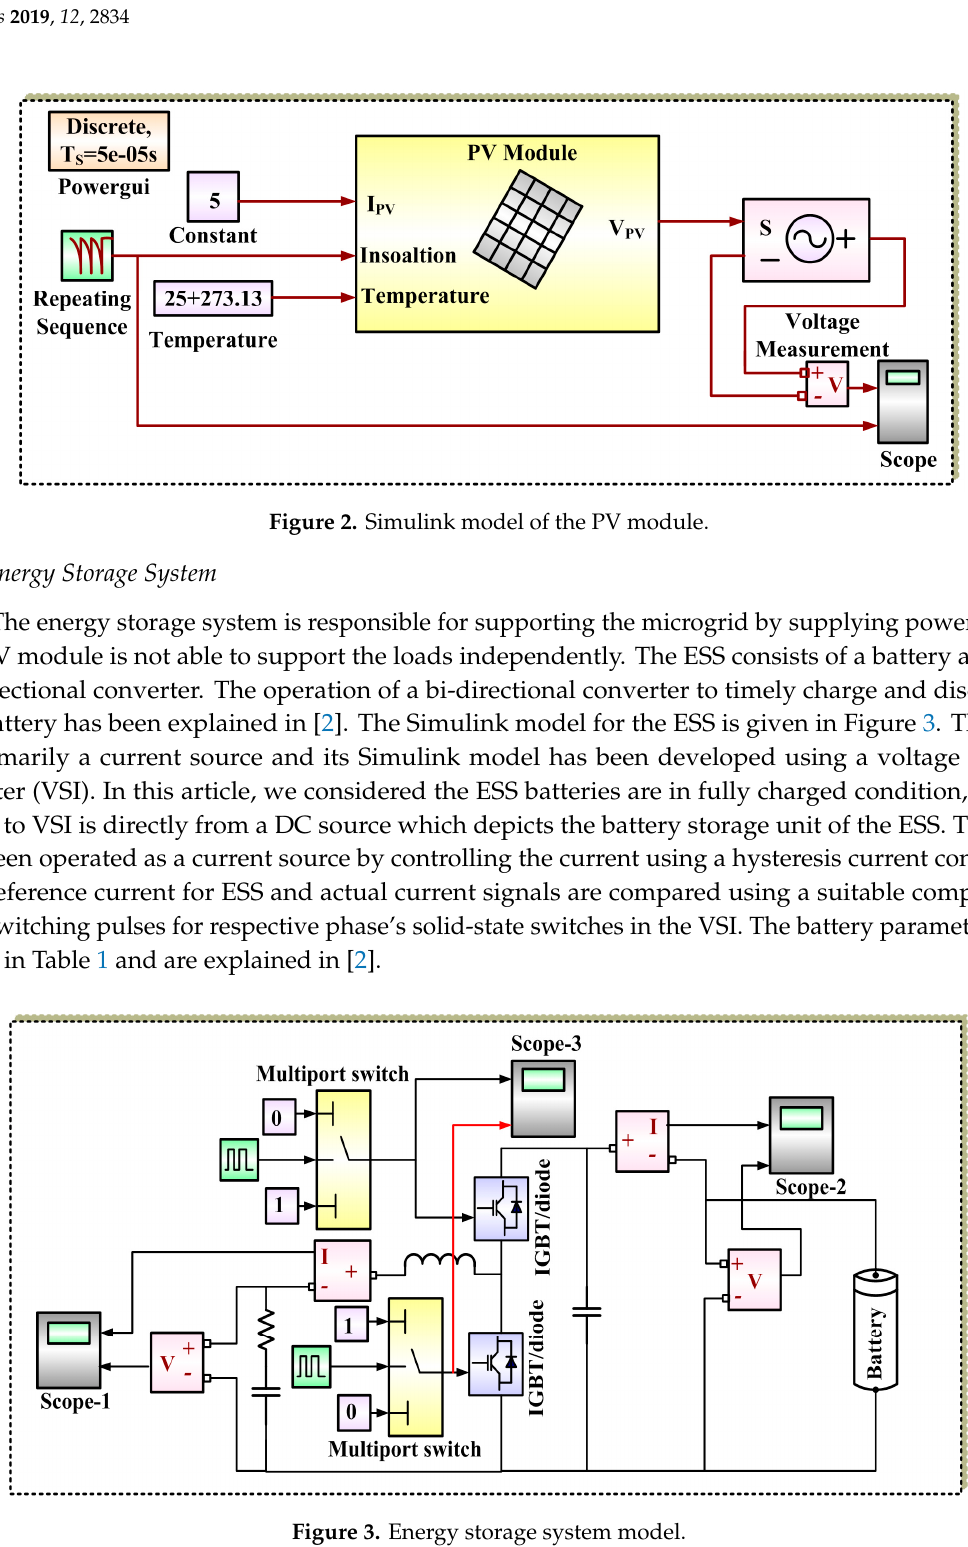
Figure 3. Energy storage system model. Table 1. Parameters of the battery in the ESS.